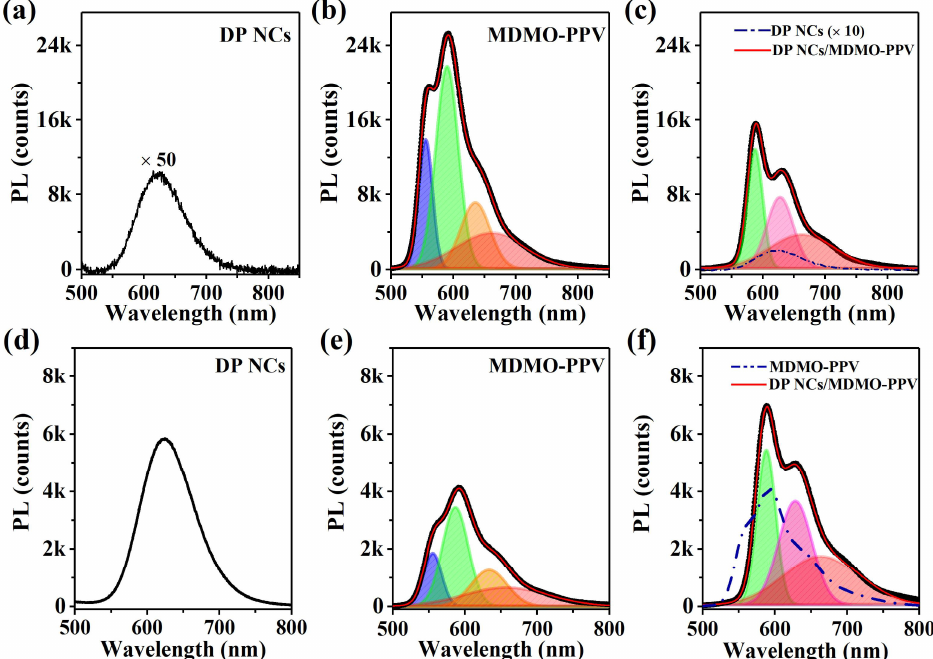
Figure 2. ( a ) PL emission spectrum of DP NCs and ( b ) PL emission spectra (black point) of MDMO- PPV polymers in toluene with their corresponding four-peak Gaussian fits at 555 nm (blue), 590 nm (green), 635 nm (orange), and 660 nm (red), as well as ( c ) PL emission spectra of DP NCs/MDMO-PPV nanocomposites and their corresponding three-peak fitting at 590 nm (green), 628 nm (pink), and 660 nm (red) under UVA excitation. ( d ) PL spectrum of DP NCs and ( e ) PL emission spectra (black point) of MDMO-PPV polymers in toluene with their corresponding four-peak Gaussian fits at 555 nm (blue), 590 nm (green), 635 nm (orange), and 660 nm (red), as well as ( f ) PL emission spectra of DP NCs/MDMO-PPV nanocomposites and their corresponding three-peak fitting at 590 nm (green), 628 nm (pink), and 660 nm (red) under UVC excitation.